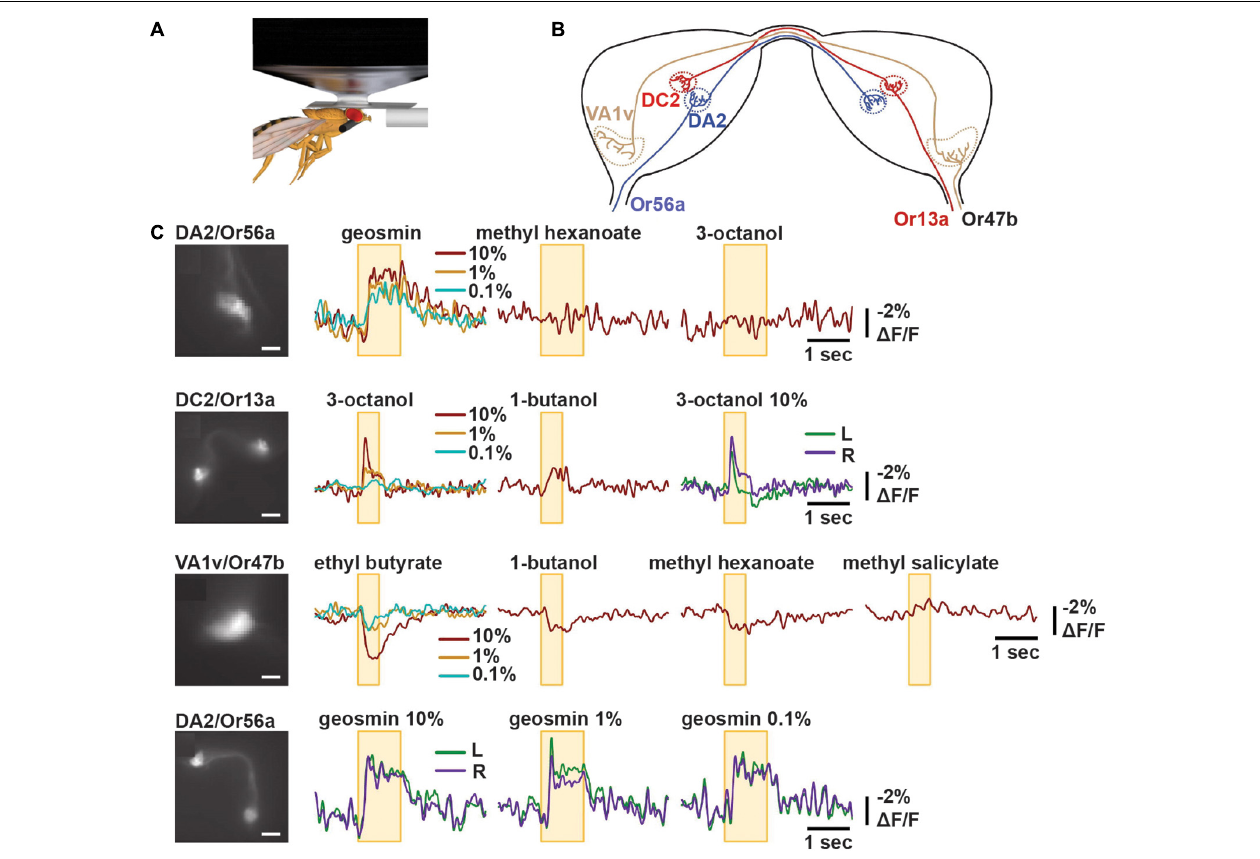
FIGURE 4 | ArcLight reports odorant responses in single trial recordings in Drosophila . (A) Schematic representation of in vivo imaging experiment of Drosophila antennal lobe following odorant presentation. (B) Schematic diagram of bilateral antennal lobes displaying projections of OSNs expressing Or56a, Or13a, or Or47b to their respective glomeruli. (C) Representative optical recordings of membrane activity at presynaptic terminals of OSNs following indicated odor application. The yellow box indicates the time of odor application. The colors indicate the different odorant concentrations 10, 1, or 0.1% or recordings obtained from the left (L) or right (R) glomeruli. Scale bars = 10 µ m (panel 2 and 4) and 20 µ m (panel 1 and 3) (Cao et al.,